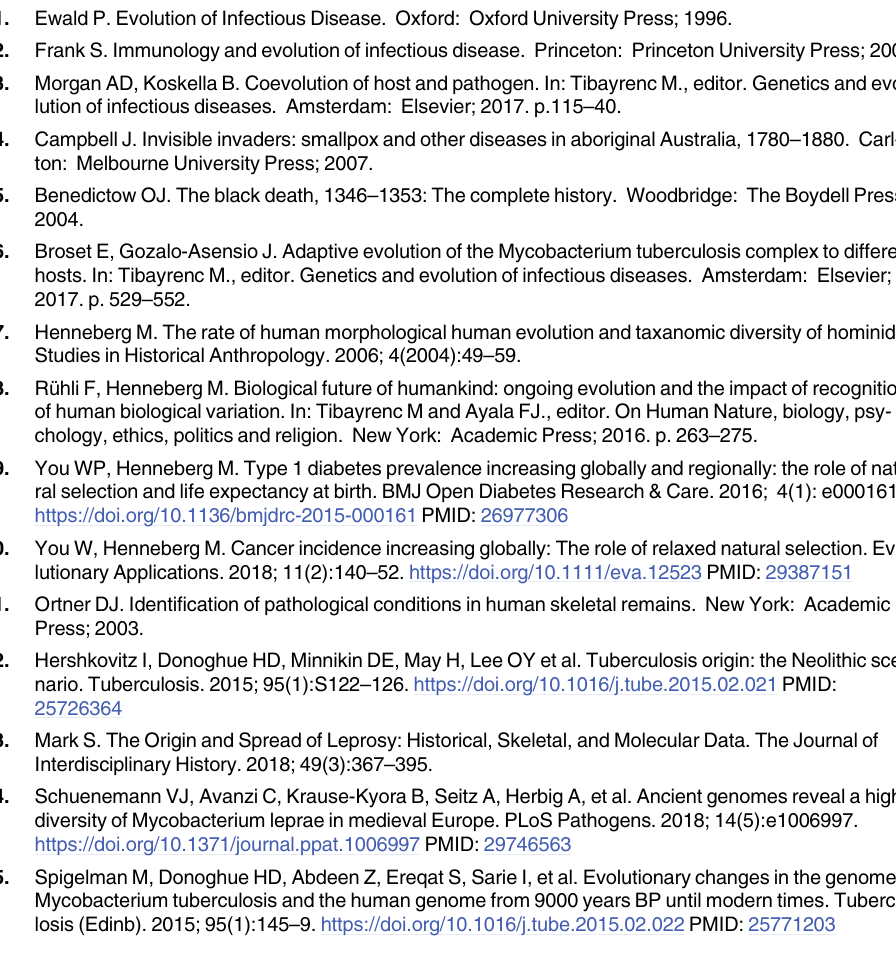
S1 Table. Data used. Locations, dating, sample size and numbers of pathological cases for each of the studied